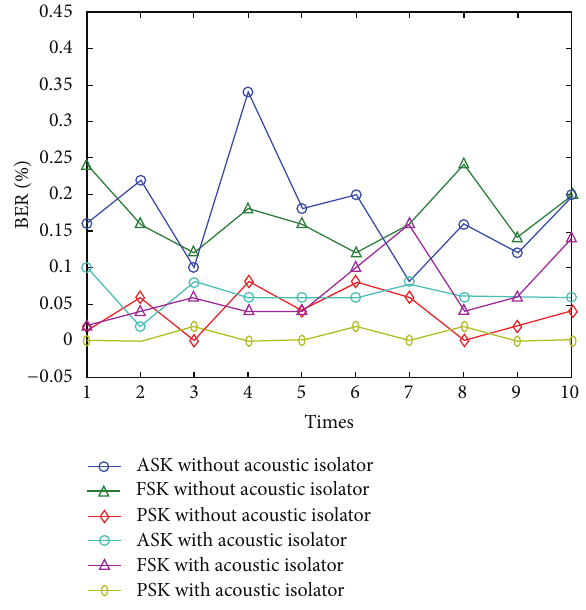
Figure 9: The BER simulation curves of ASK-, FSK-, and PSK- modulated data in the absence and the presence of combine acoustic